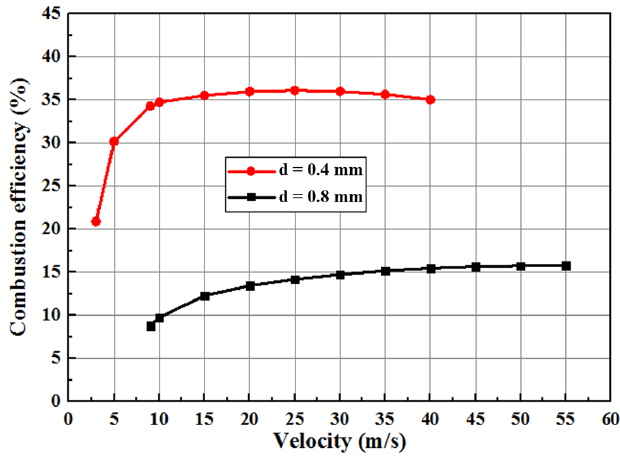
Figure 4. The relationships between combustion efficiency and jet velocity for the two combustors with different nozzle exit diameters.